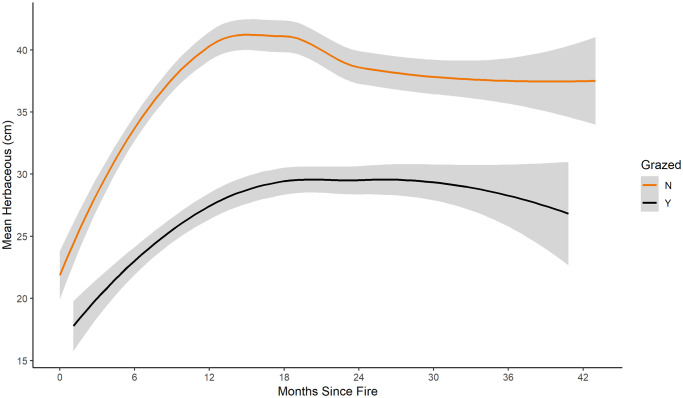
Mean herbaceous vegetation.Mean height (cm) of herbaceous vegetation in fire-only (orange) and pyric herbivory (black) treatments at all sites from 2014 to 2016. Shaded area indicates 95% confidence interval. *Regression lines and confidence intervals generated using “loess” locally-weighted smoothing function.